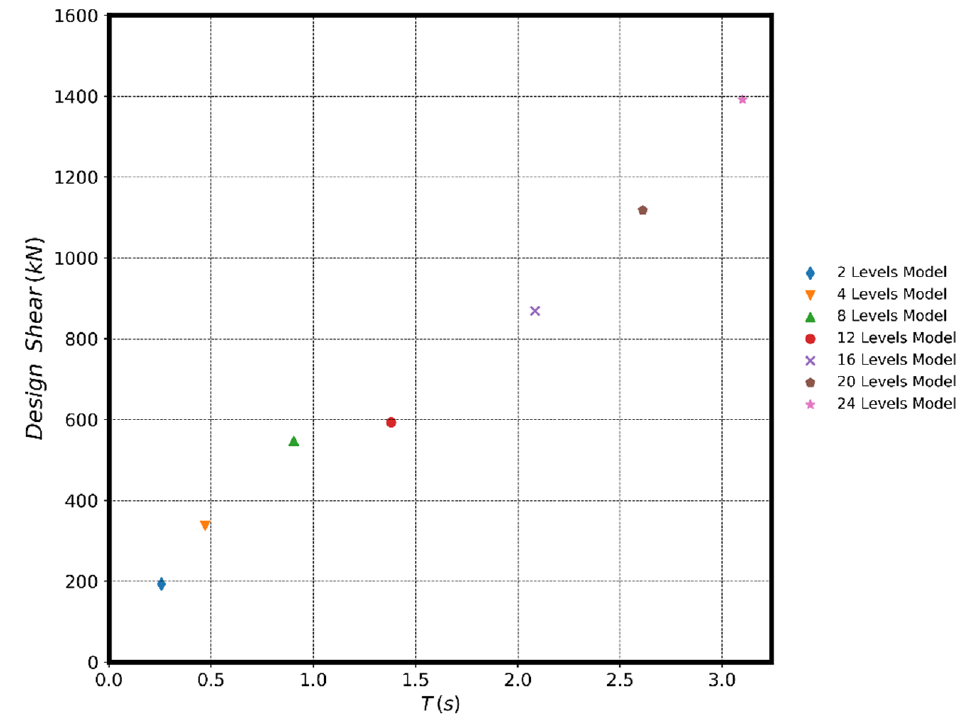
Figure 3. Design shear versus period for the models